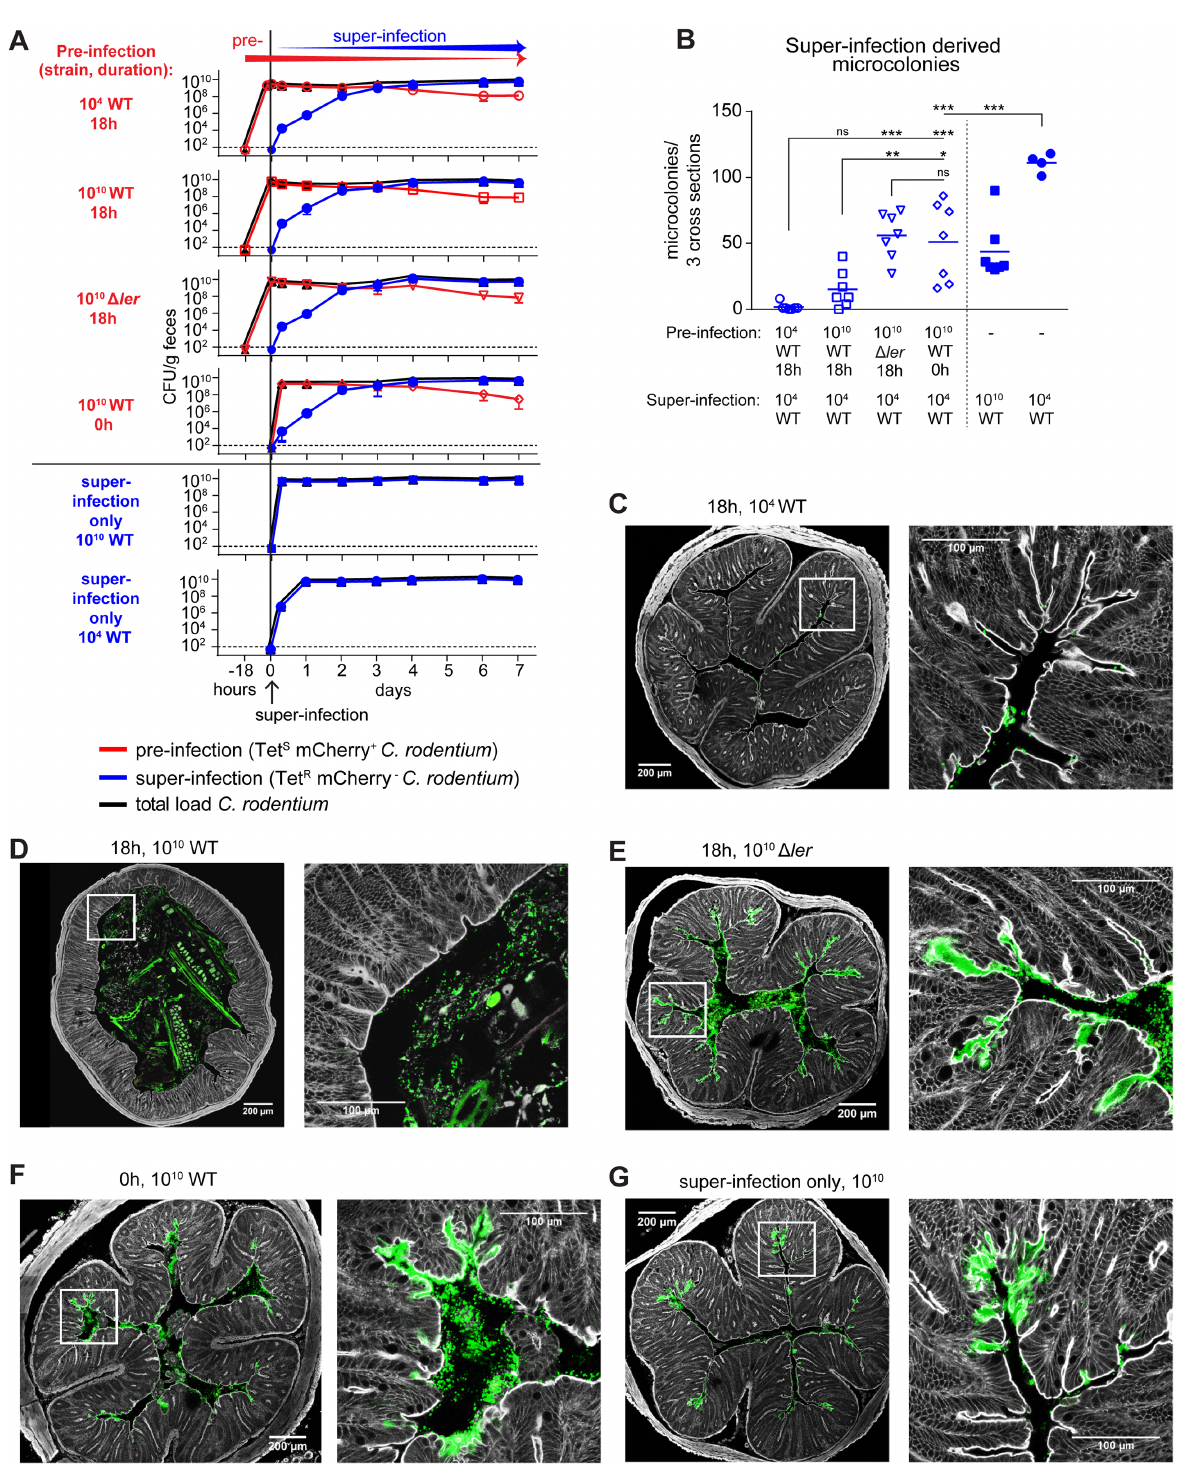
Fig 4. An early window of opportunity for A/E microcolony induction in wild-type mice. ( A ) Colonicluminalcolonization trajectories of the pre-infectionstrain (red open symbols: circles, 10 4 CFU Wild type C . rodentium [WT]; squares, 10 10 CFU WT; inverted triangles; 10 10 CFU Δ ler mutant), the super-infection strain (blue filled symbols: circles, 10 4 CFU WT; squares, 10 10 CFU WT), and total bacteria (pre-infection + super-infection strain; black triangles). Connectinglines connect means; error bars indicate standarddeviations. Horizontaldotted lines indicatethe lower detectionlimit. ( B ) Microcolony formation of superinfection strain after 7 days. N = 6–7 per